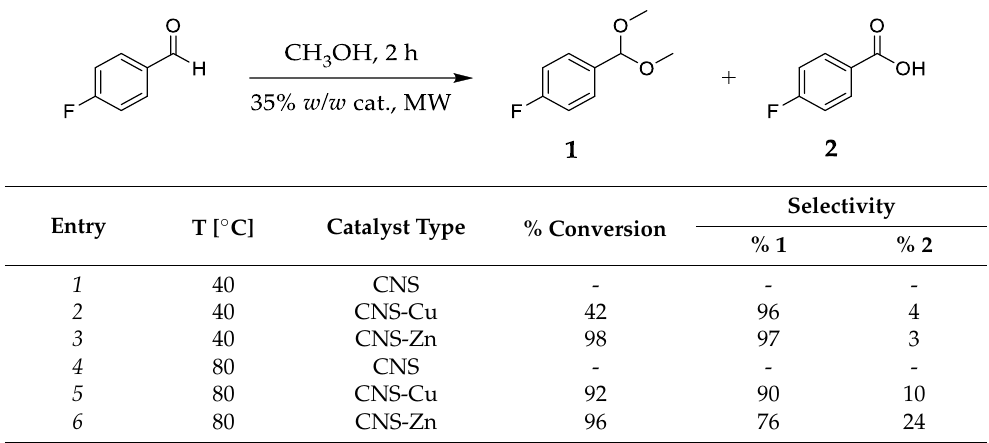
Figure 2. Distribution of elements on CNS-Cu observed with EDS analysis.